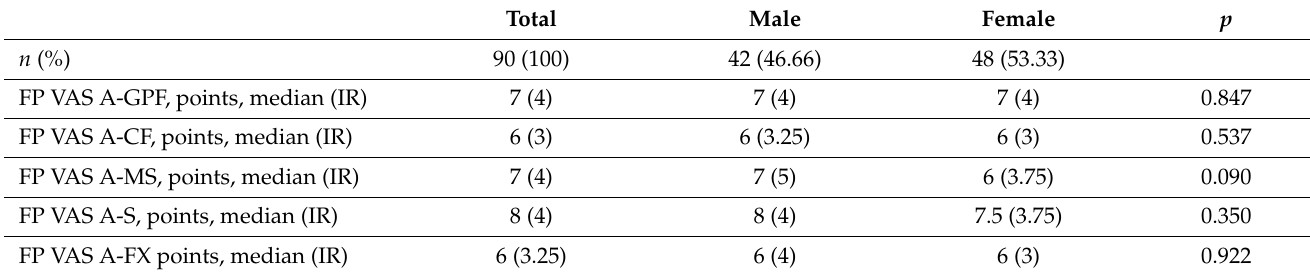
Table 2. FP VAS A scores for total sample and between-sex